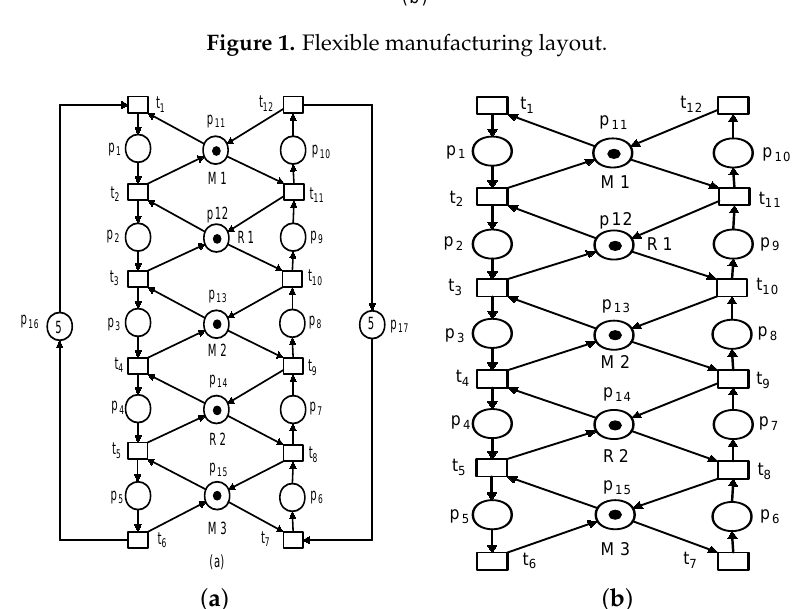
Figure 2. ( a ) Petri net model ( N , M 0 ) ; ( b ) a subnet model N = ( N (cid:48) , M 0 ) with N (cid:48) = ( P (cid:48) , T (cid:48) , F (cid:48) )